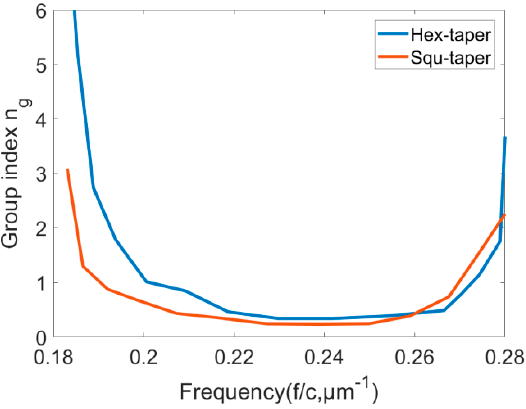
Figure 9. Deduced group index curves ( 𝑛 (cid:3034) ) vs. wavelength for different tapers.